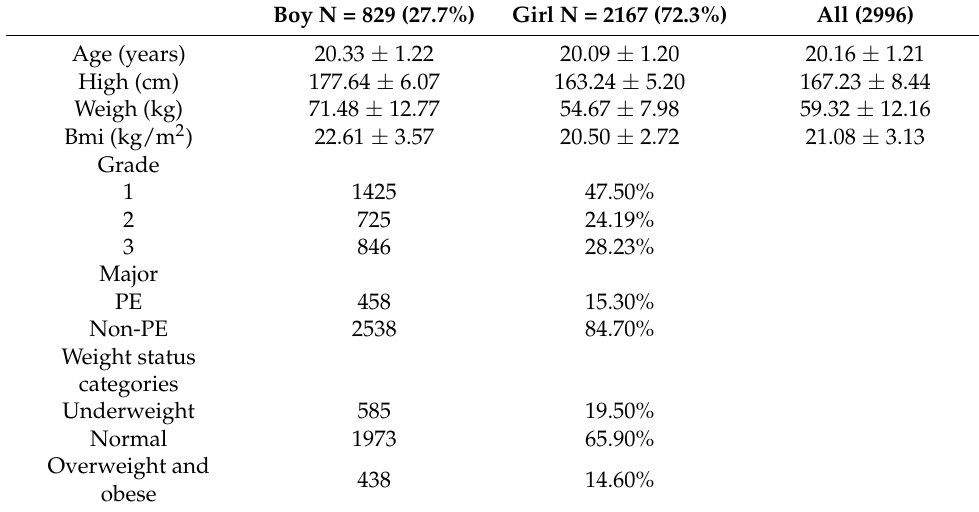
Table 1. Characteristics of students.